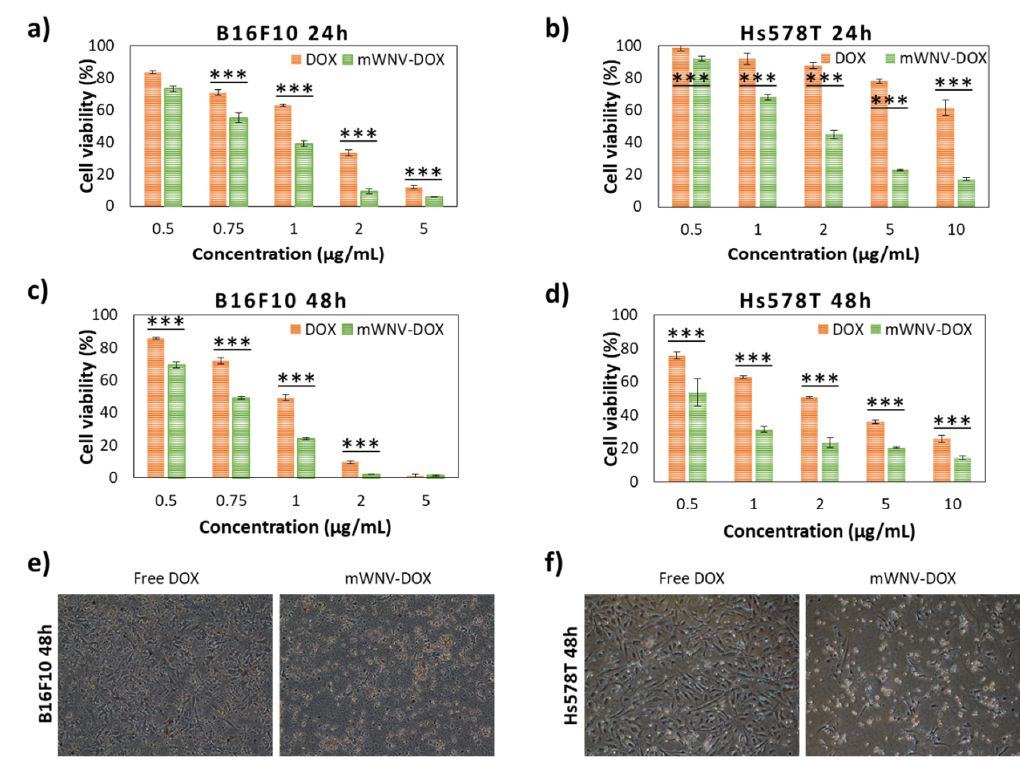
Figure 2. Cell viability of B16F10 cells in 2D cultures after 24 ( a ) and 48 h ( c ) of exposure to a wide range of DOX (red) and mWNV-DOX (green) concentrations (0.5–10 µg DOX/mL). Cell viability of Hs578T cells in 2D cultures after 24 ( b ) and 48 h ( d ) of exposure to a wide range of DOX (red) and mWNV-DOX (green) concentrations (0.5–10 µg DOX/mL). All differences between DOX and mWNV-DOX are statistically significant at a 99.9% confidence level (***), except B16F10 at 48 h at a concentration of 5 µg DOX/mL. ( e , f ) Phase contrast images of B16F10 ( e ) and Hs578T ( f ) cells exposed to DOX and mWNV-DOX at a concentration of 1 µg DOX/mL.